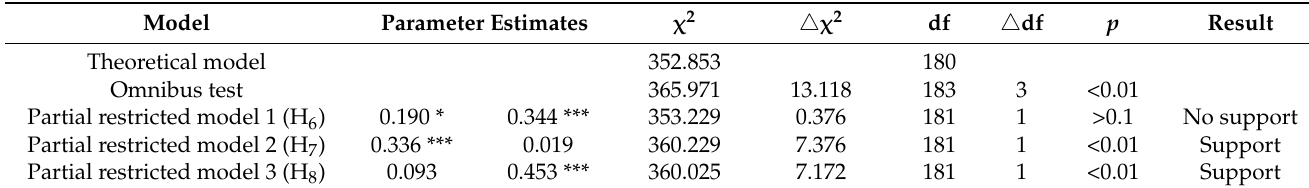
Table 3. Test for differences in parameter